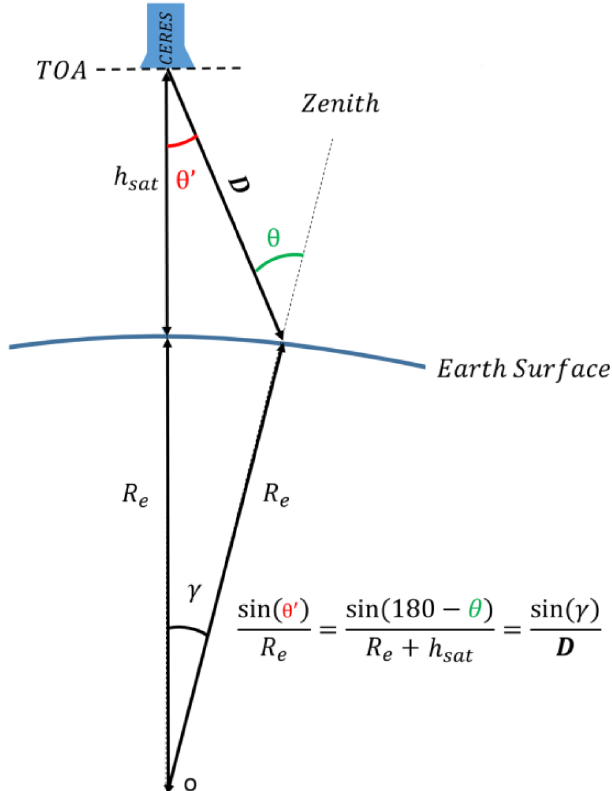
Figure A1. Geometry for Eq. (A1).